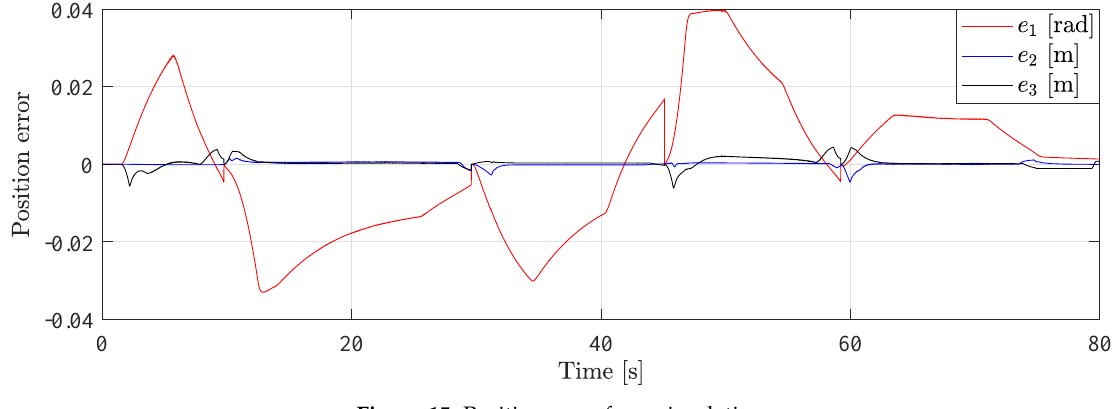
Figure 15. Position error from simulation.